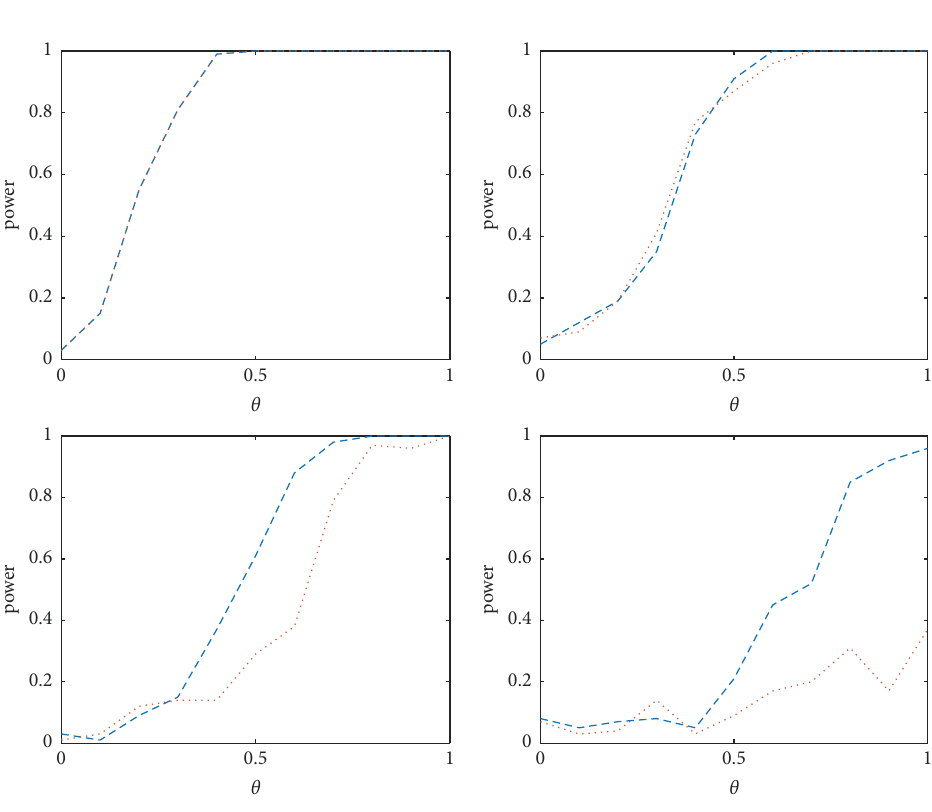
Figure 1: Powers of the tests. Dashed: T